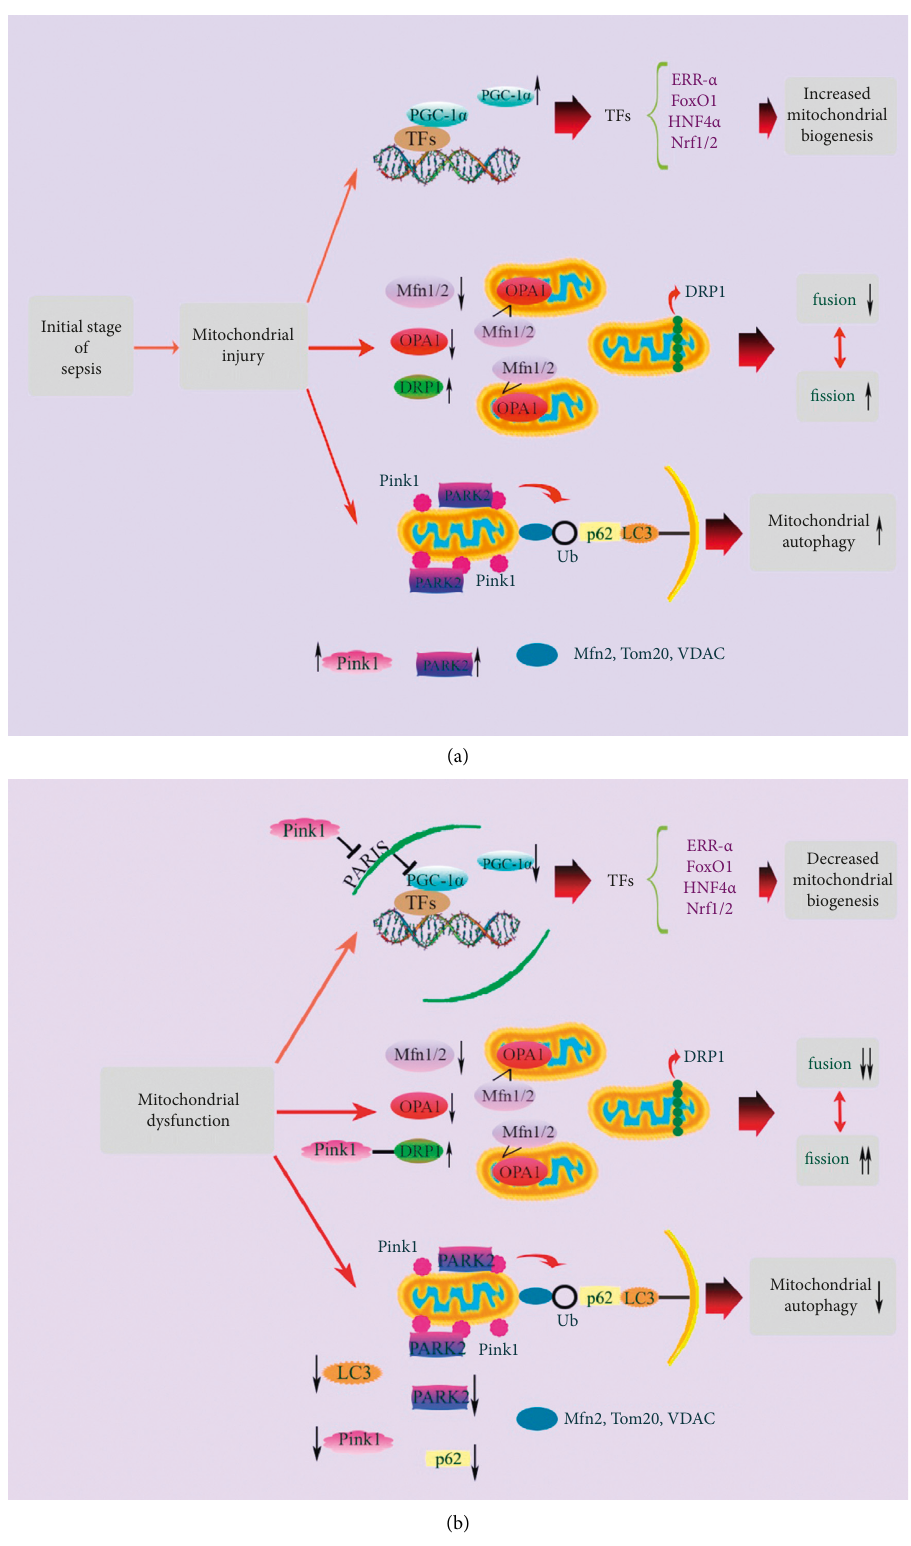
Figure 1: Mitochondrial quality control mechanisms under septic challenge. The upregulation of PGC-1 α and transcription factors in the initial stage of sepsis promotes mitochondrial biogenesis. Decreased Mfn1/2 and OPA1 and increased DRP1 expression levels shift the balance of mitochondrial fusion and fission toward mitochondrial fission. Pink1 accumulation on mitochondria causes PARK2 trans- location from cytoplasm into mitochondrial outer membrane and activation of mitophagy (a). With sepsis development, damaged mi- tochondria cannot be recovered and turn into mitochondrial dysfunction. The downregulation of PGC-1 α and transcription